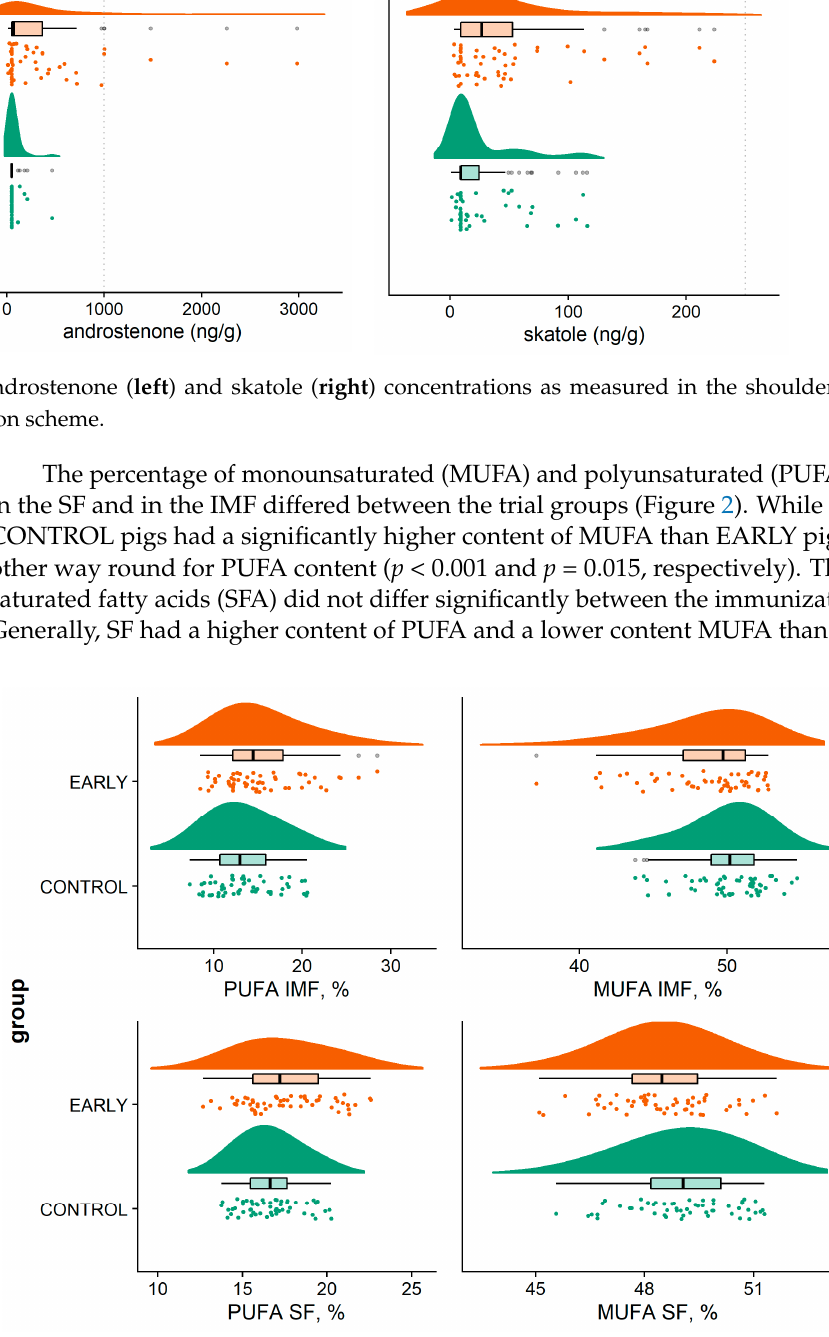
Table 1. Testes weight and development according to immunization scheme. Immunization